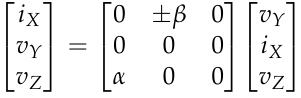
Figure 4. Real second-generation voltage conveyor. Finally, we should note that, as for the CCII, some generalizations of the VCII with differential inputs and outputs or non-unitary controllable gain have been proposed [36,39], albeit to a more limited extent with respect to the CCII. This represents a research topic in current-mode processing. 2.3. Basic CCII and VCII Configurations Using VCII or CCII, it is possible to realize common analog signal processing circuits. Depending on the specific application, we find that VCII and CCII are very useful blocks in configurations where classical operational amplifiers are limited, notably in those that require operation on current signals such as current differentiation and integration [44]. Moreover, even in those applications where op-amps provide well-established solutions, CCII and VCII can perform the same tasks but with some important advantages such as higher bandwidth, speed, dynamic range, and lower consumption. The bandwidth im- provement is due to the fact that, unlike in voltage mode circuits, where the constant gain- bandwidth product (GBW) represents the main trade-off that limits the obtainable band- width, in CCII and VCII this limitation is overcome through the concepts of voltage and current conveying. Since current conveying means unitary gains, the bandwidth is max- imized to the GBW value for the current buffer and voltage buffer stages of a CCII or VCII, but at the same time, the availability of a current input or output terminal allows for signal amplification, as shown in the following. Moreover, the current terminal provides even more flexibility than that offered by op-amps, since it makes it easier to perform any cur- rent-to-voltage conversion or vice versa. As for the dynamic range improvements, this is because, using current as an information-bearing signal, it is possible to allow high signal